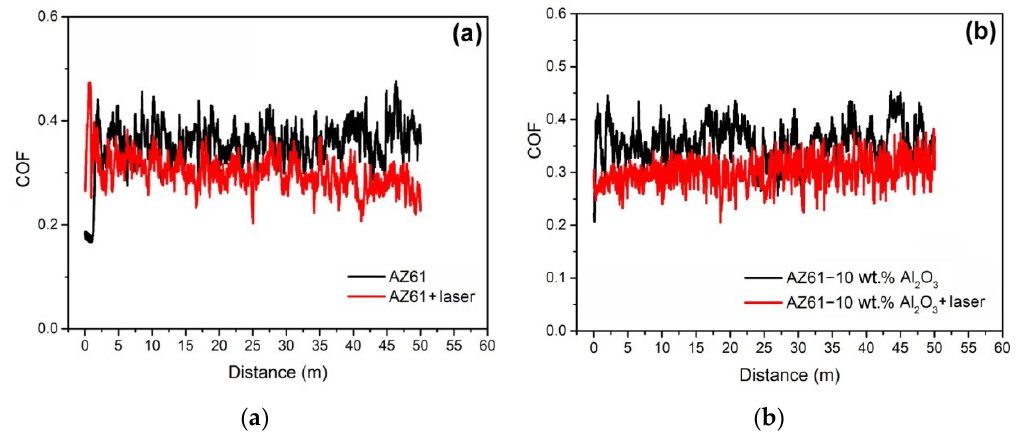
Figure 7. Variation of instantaneous COF values depending on the sliding distance during the tribological tests at a sliding speed of 100 mm/s and normal load of 5N for: ( a ) AZ61 base material; ( b ) AZ61–10 wt.% Al 2 O 3 nanocomposite.